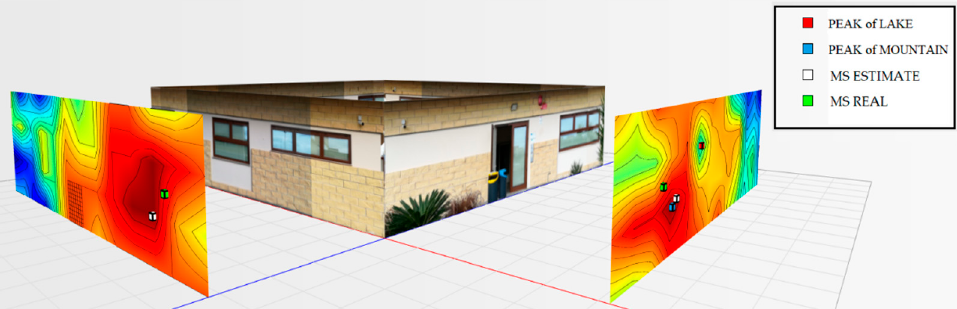
Figure 27. Overview of the power levels for walls 1 and 2, room terminal on the left at 1.5